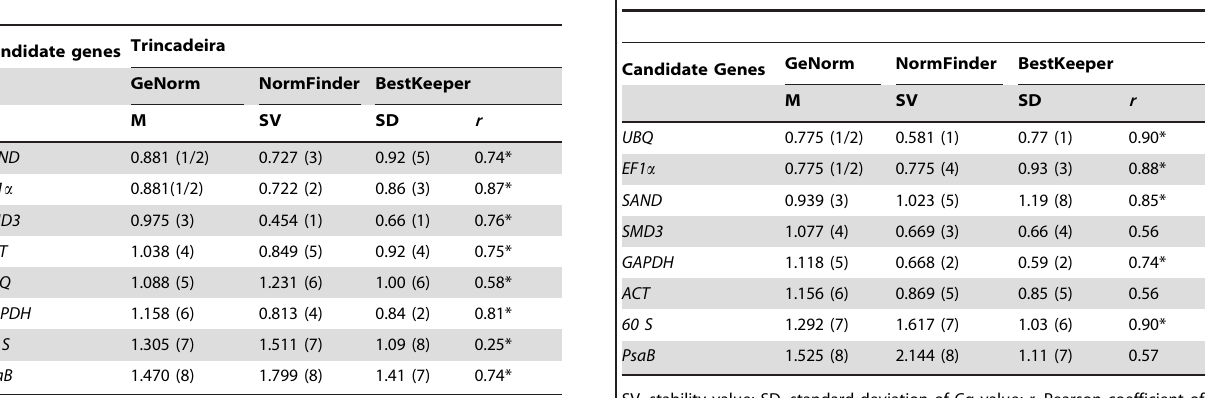
Table 4. Candidate reference genes for Genotype effect